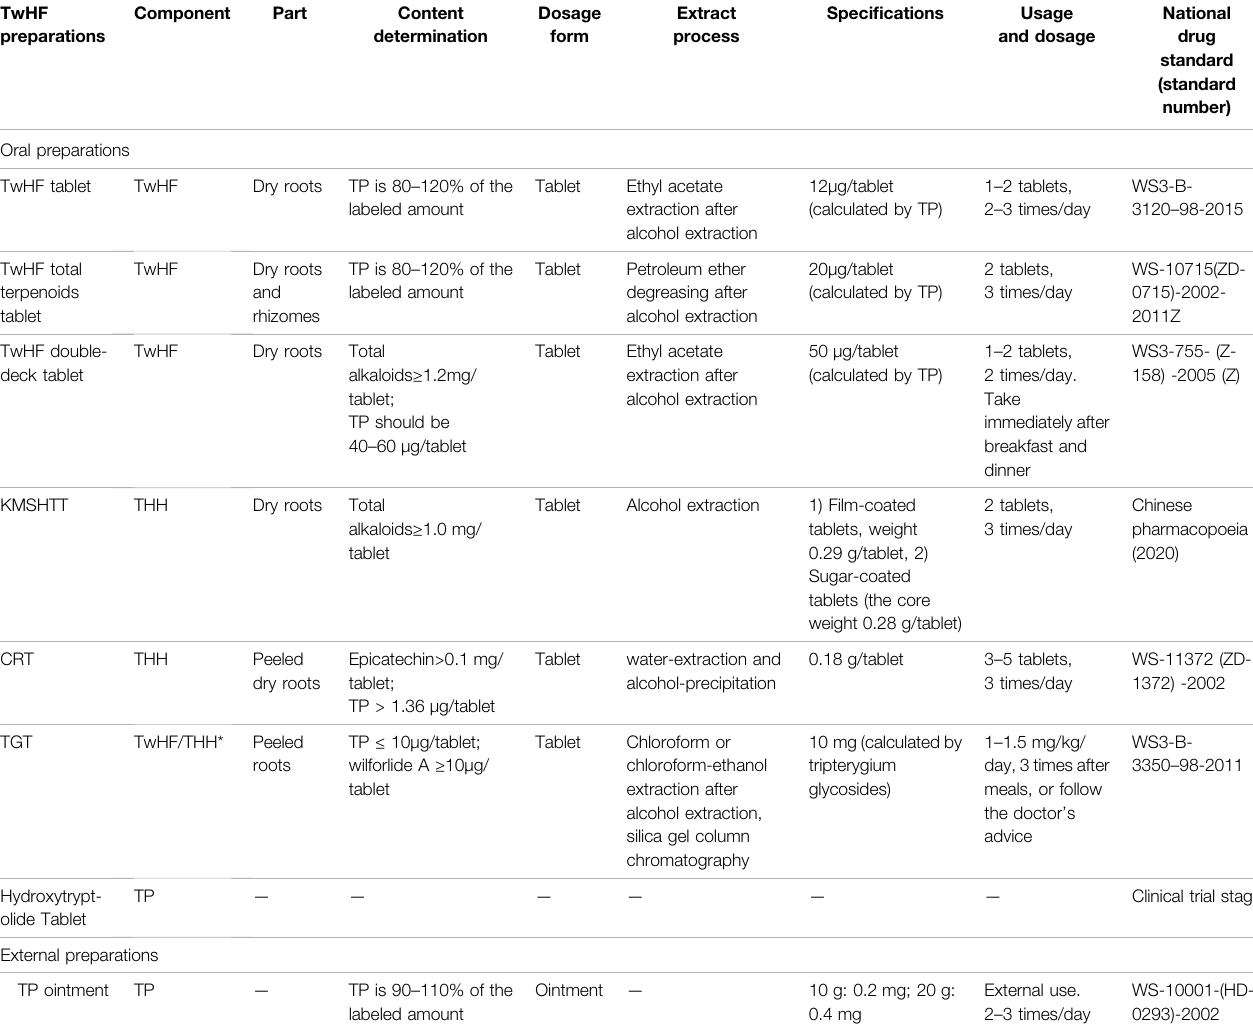
TABLE 2 | Single TwHF preparations.